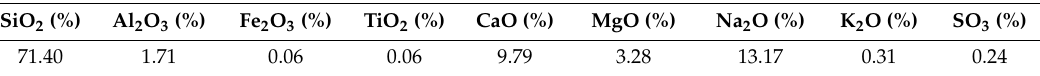
Table 1. Composition of typical glass container (nonantibacterial) glass composition.